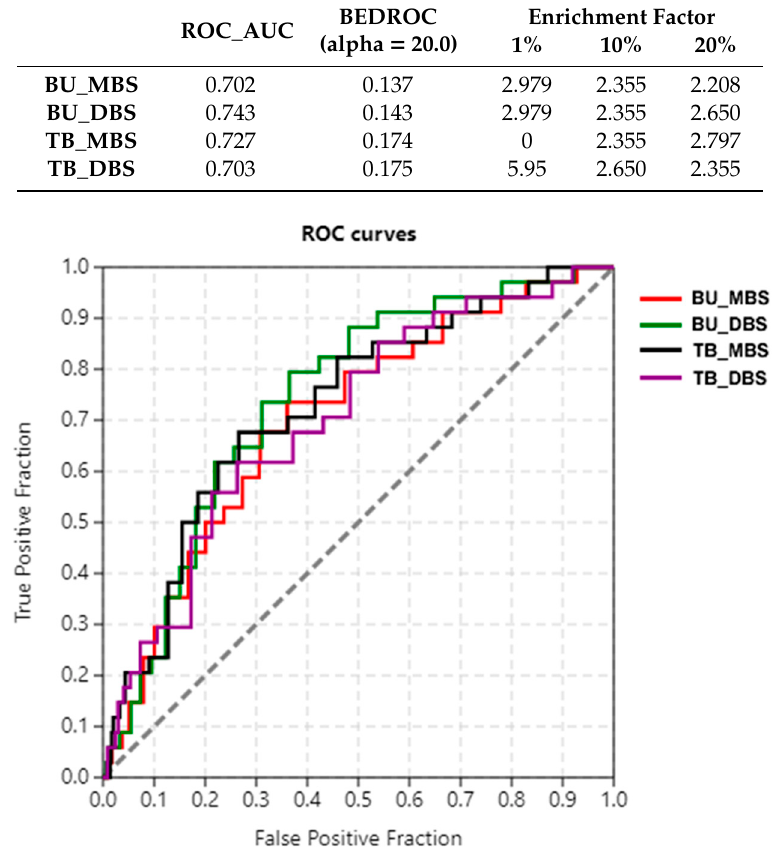
Table 4. Respective values of ROC_AUC, BEDROC and Enrichment Factor for the metal binding site 2 and DNA- binding sites of ideR for M. ulcerans (BU_MBS and BU_DBS) and that of M. tuberculosis (TB_MBS and TB_DBS).